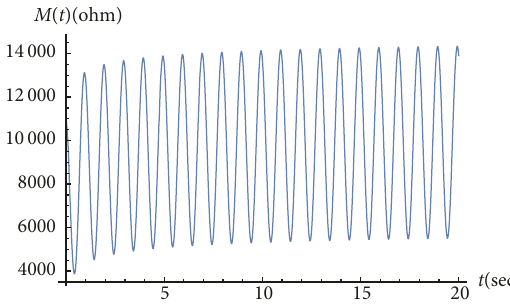
Figure 14: 𝑀(𝑡) of the fractional order memristor under the sinusoidal input with 𝐼 𝑚 > 0: 𝛼 = 0.75